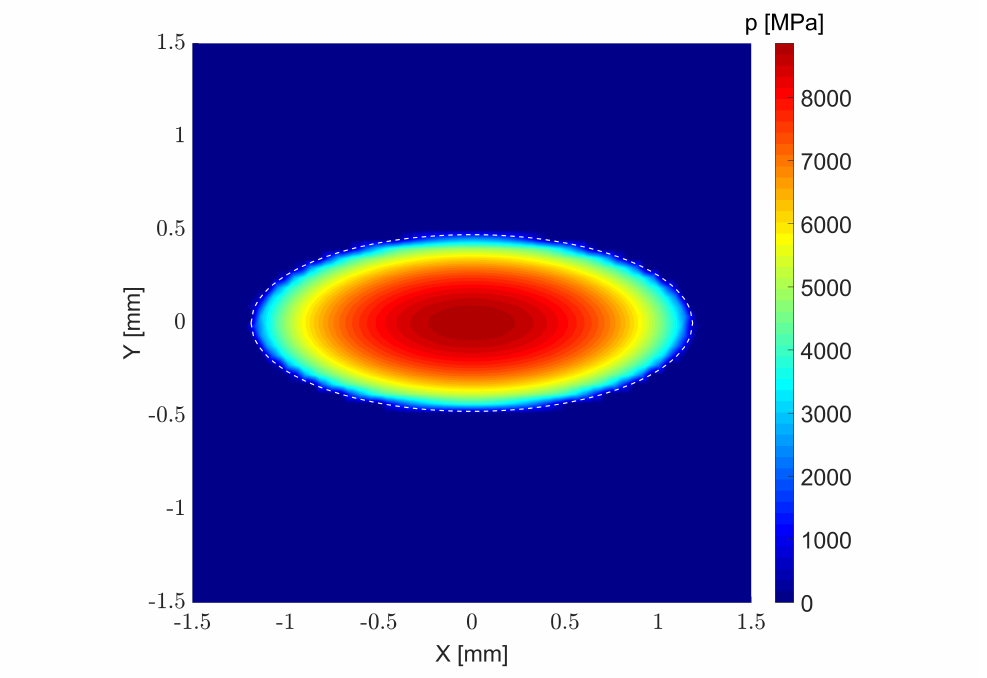
Figure 6. Pressure distribution for the ellipsoid–ellipsoid